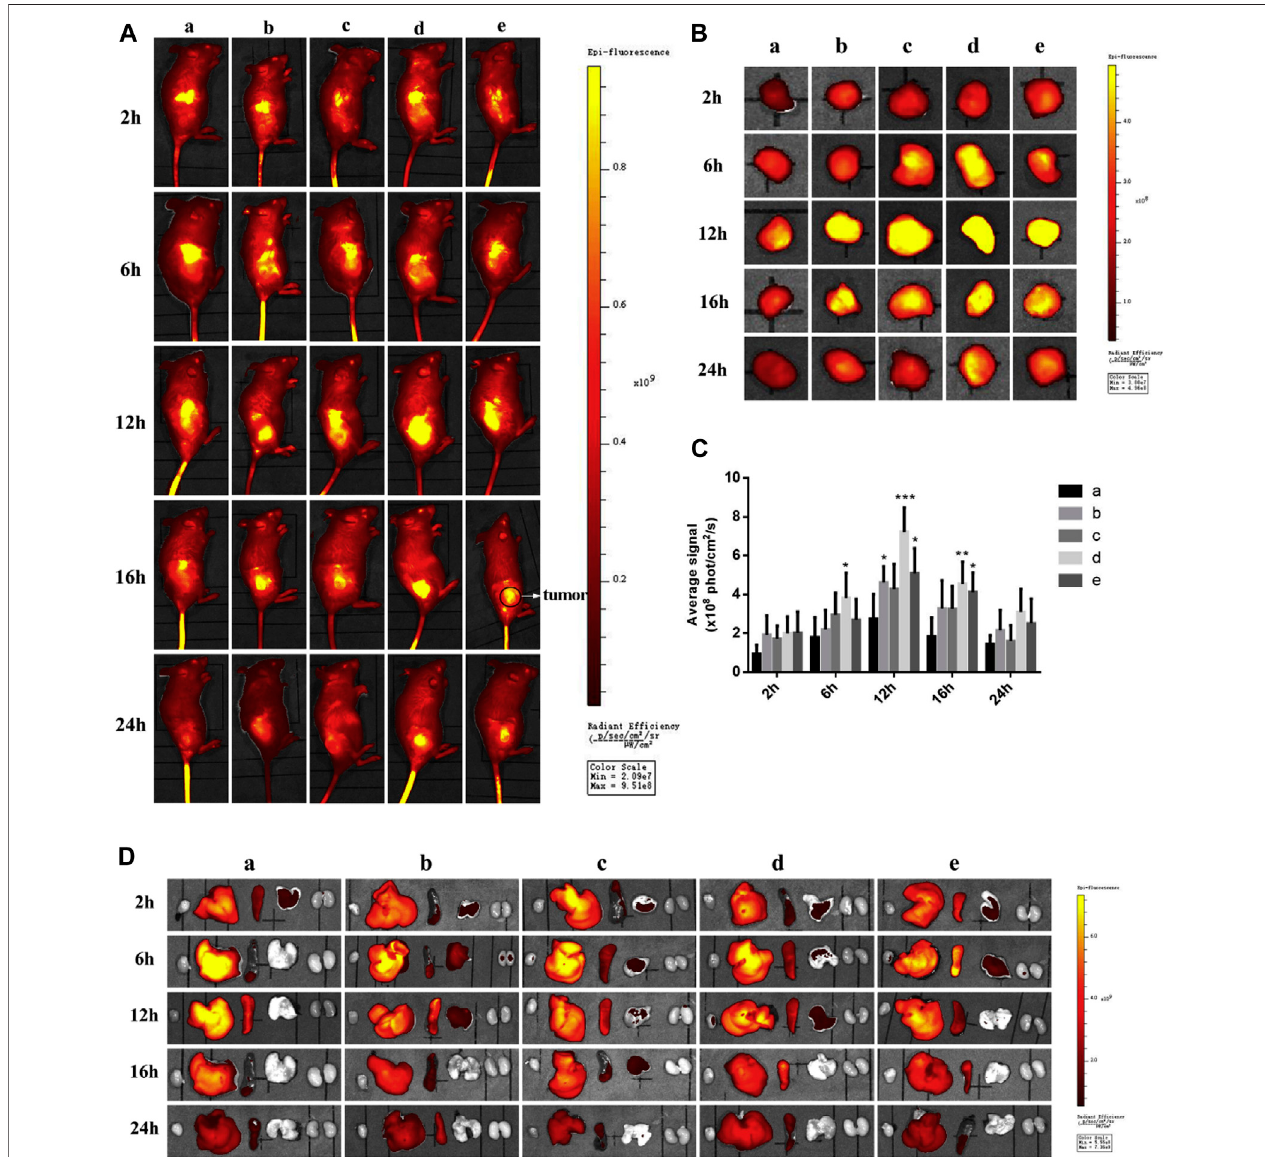
FIGURE3| In vivo (A) and ex-vivo images (B) 4T1bearing mice treated with (i) DID-Lip (ii) DID-FRU-Lip (iii) Did-RGD-Lip (iv) Did-RGD/FRU/Lip and (v) Did-RGD- FRU-Lip. Among the modi fi ed liposome (iv) showed strongest fl uorescent intensity due to targeting effect. (https://doi.org/10.1016/j.ejmech.2019.111720).